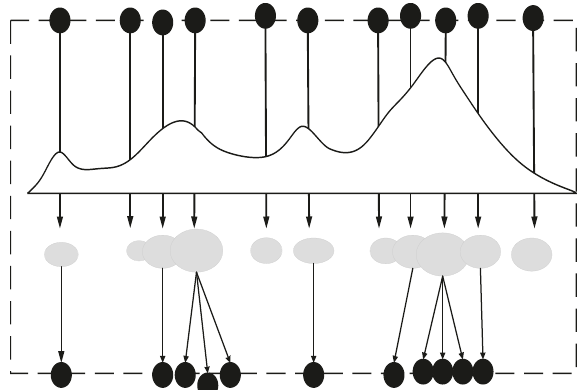
Figure 6: Implementation process of particle filter algorithm.